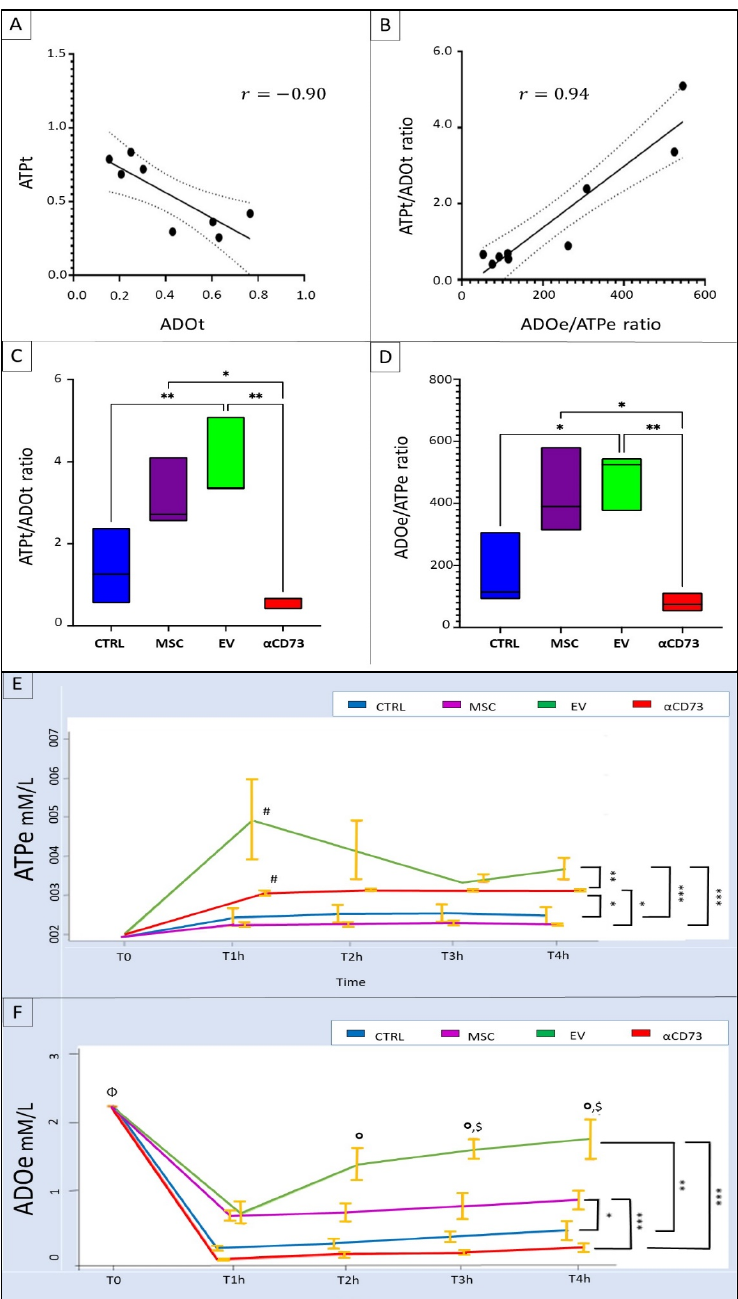
Figure 8. Tissue and effluent purines. ( A ) Negative correlation between tissue adenosine (ADO) and adenosine triphosphate (ATP) concentrations (r = − 0.90, p < 0.001). ( B ) Positive correlation between effluent and tissue purine ratios (r = 0.94, p < 0.0001). ( C ) Comparison of the purine ratio in the tissues between different groups. ( D ) Comparison of the purine ratio in the effluent between different groups. ( E ) Variation in effluent ATP levels with time in each group. ( F ) Variation in effluent ADO levels with time in each group. The symbol at the end of the line indicates a significant difference at all time points during hypothermic perfusion. * p < 0.05; ** p < 0.01; *** p < 0.001; #T0 vs. T1h p < 0.01; Φ vs. T0 p < 0.0001; $ vs. EV T1h p < 0.01; ◦ vs. MSC p < 0.001. CTRL, control group; MSC, mesenchymal stromal cell group; EV, extracellular vesicle group; α CD73, CD73-silenced group; T, time since start of hypothermic perfusion (1, 2, 3, or 4 h after the start [T0] of hypothermic